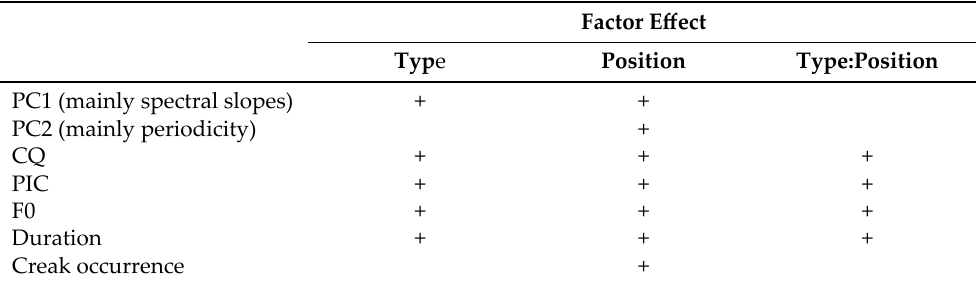
Table 10. A summary of fixed factors on phonetic realization. Significant effects are indicated with plus